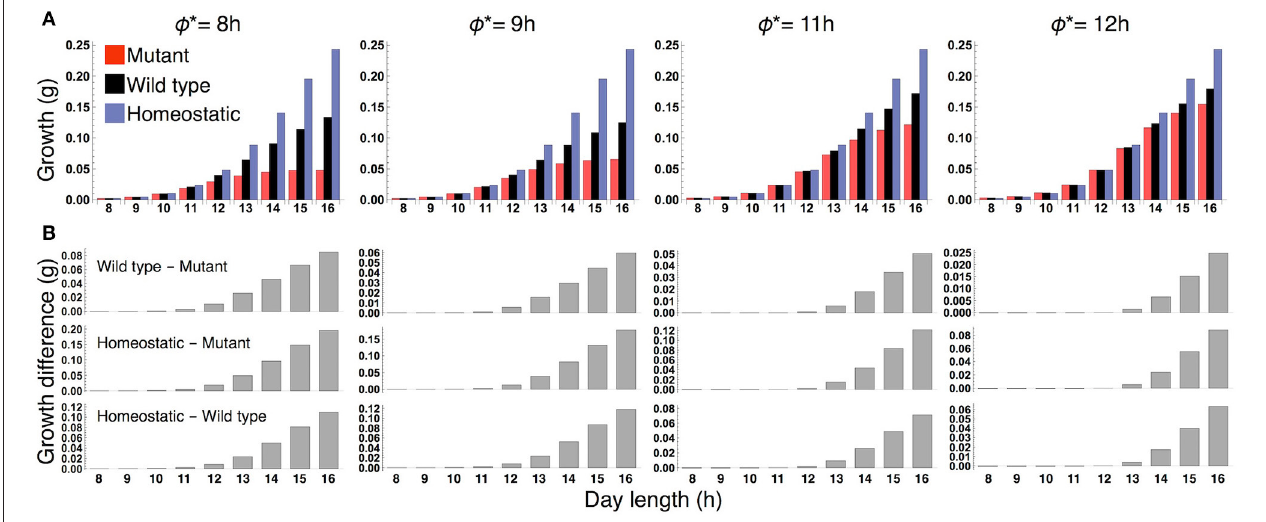
FIGURE 6 | (A) 10-day growth of the sink (SAM or RAM) of the mutant, wild type, and homeostatic plant, and (B) growth differences among the plants at various values of the subjective dusk φ